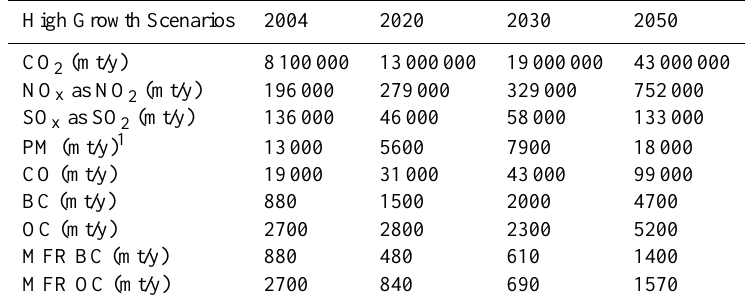
Table 9. Summary of in-Arctic emission inventories for 2004 and high-growth